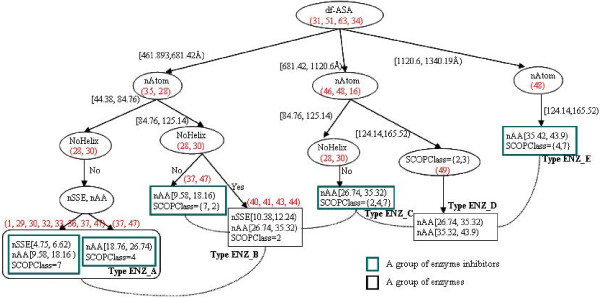
A hierarchical tree for supporting inference of subtypes. A hierarchical tree drawn from association rules (Table 7) represents different structural groups in ENZ. Enzyme-inhibitor interactions are characterized with size scales of interaction sites (number of atoms and df-ASA) and SSE content information (helix content). These differences of structural groups result in subtypes of PPIs. Letters in red are identifiers of rules (Tables 6 and 7) to split branches of a tree. Dashed lines show interaction between enzymes and inhibitors in different subtypes.